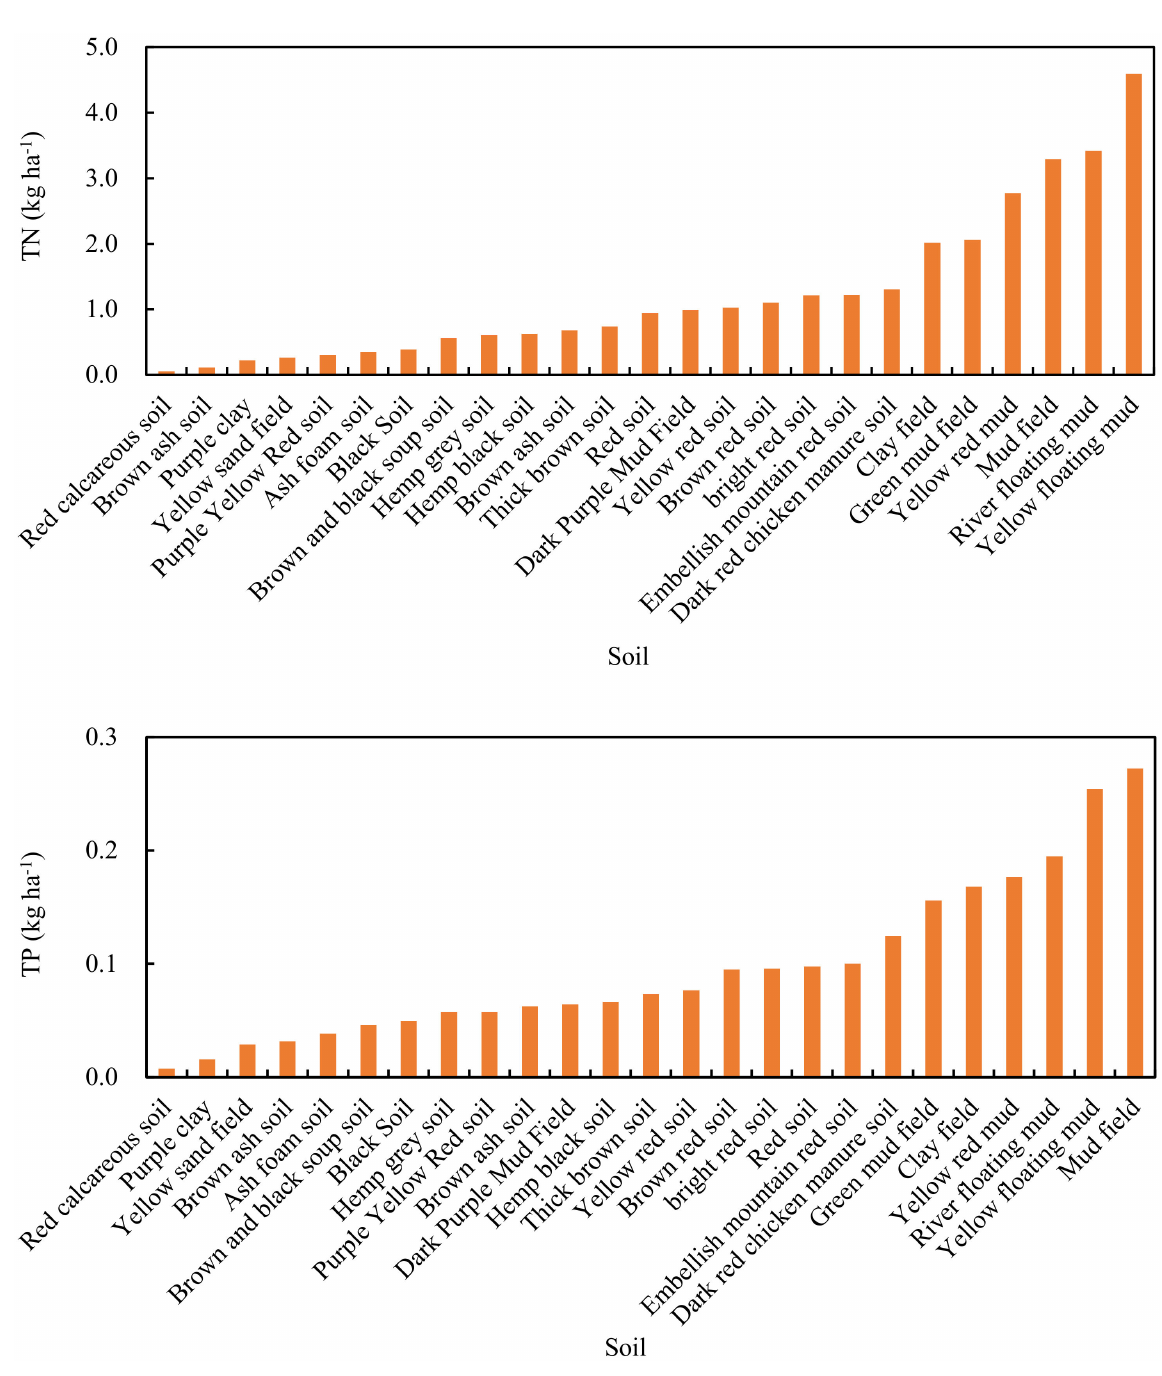
Figure 10. Pollution load intensity of different soil types in Lake Erhai watershed. Forest land, grassland, and farmland occupied the largest parts of the study area, so these three land use types were selected for analysis. Figure 12 shows the distribution characteristics of the pollution load intensities of the same land use types with different slopes. For the farmland, the TN and TP pollution load intensities into the lake had a quadratic functional relationship with the slope, and the correlation coefficients reached 0.92 and 0.91, respectively. Moreover, with the increase in the slope, the TN and TP pollution load intensities showed a bowl-shaped trend. In the zone with a slope of 0–18 ◦ , the pollution load intensity negatively correlated with the slope. The reason is that in this zone, the dynamic and gravity effects of the slope on water flow were relatively weak, so